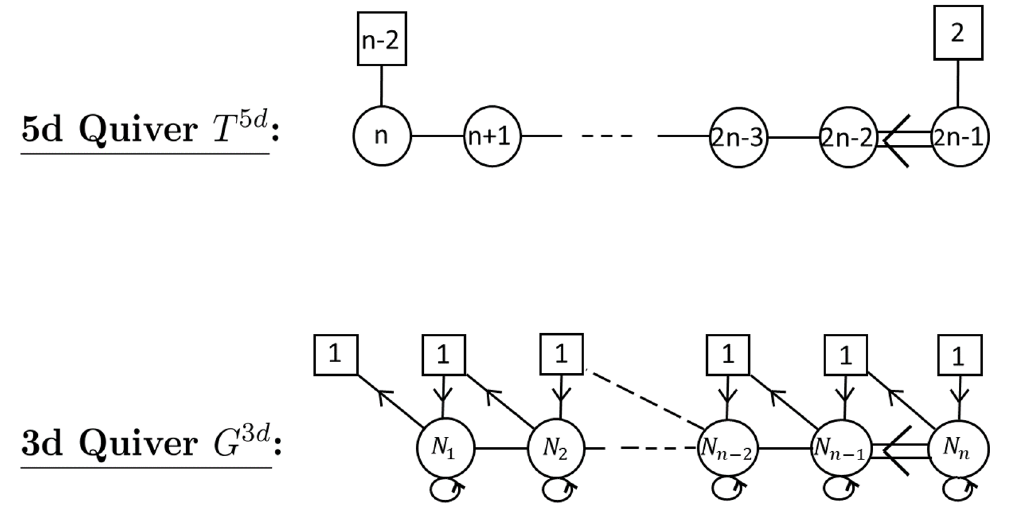
Figure 10. Sphere with 3 full C n punctures: 5d theory T 5d and 3d theory G 3d resulting from W S